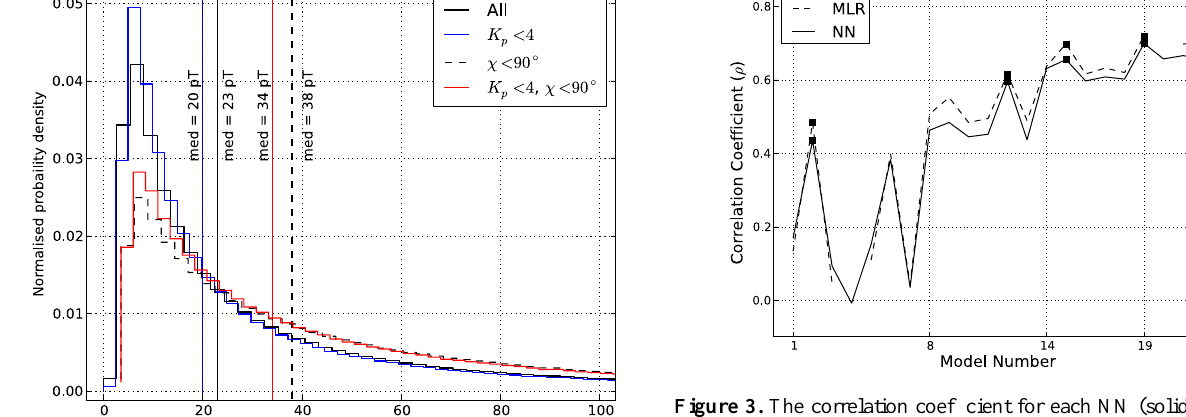
Figure 3. The correlation coefficient for each NN (solid line) and MLR (dashed line) model. The winners of each round of training are indicated with squares. The values are listed in Table